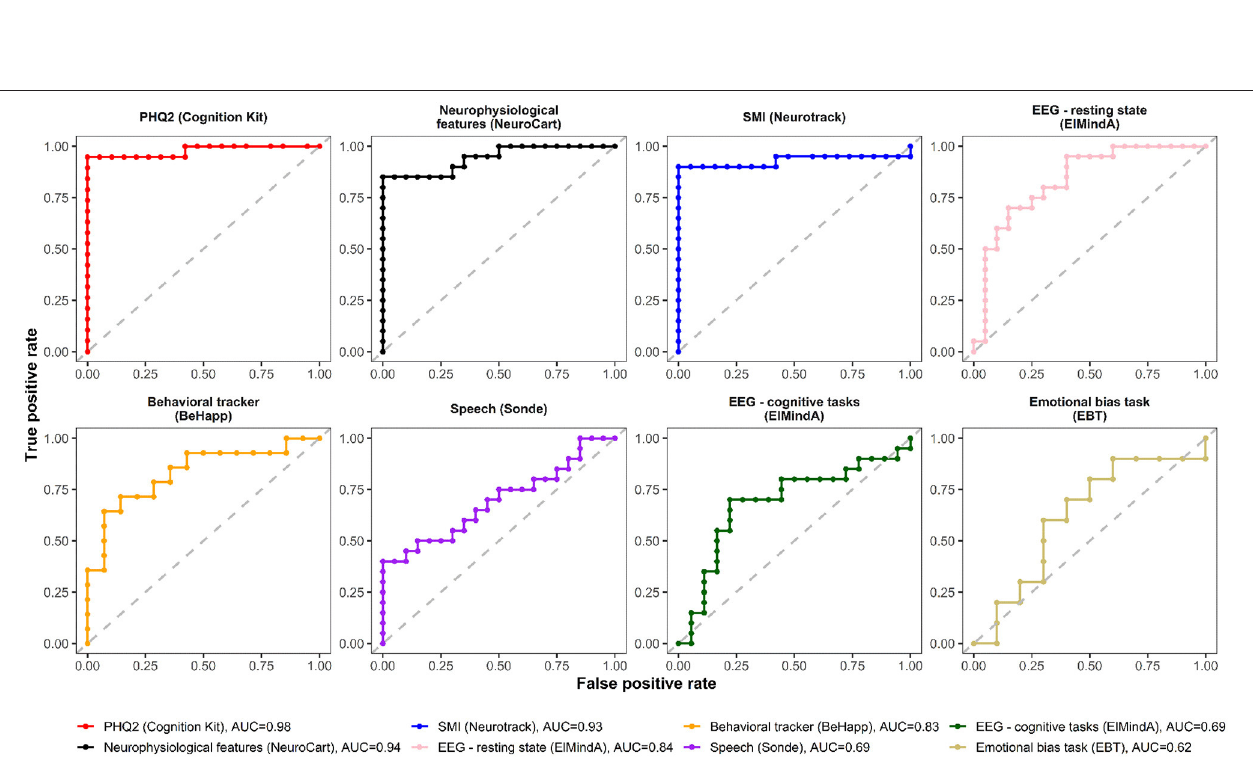
FIGURE 5 | ROC curves of classifiers based on linear model-predicted MADRS using different digital technology features.